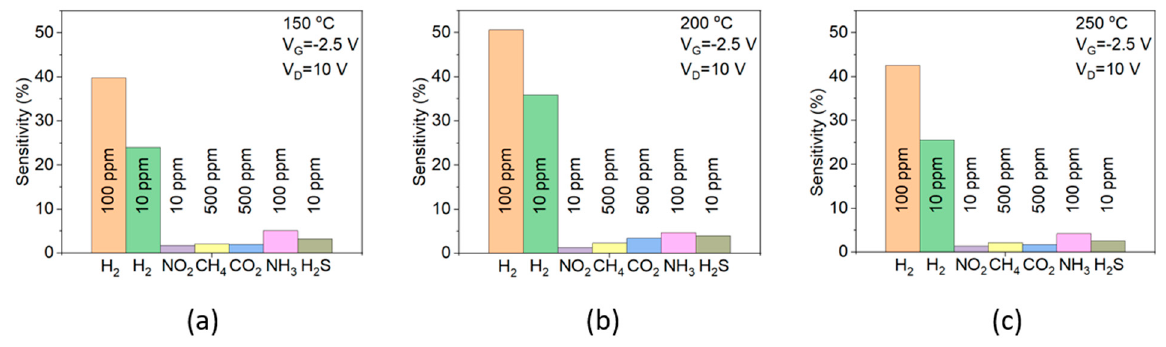
Figure 8. Hydrogen selectivity of S3 sensor at 150 °C ( a ), 200 °C ( b ), and 250 °C ( c ).